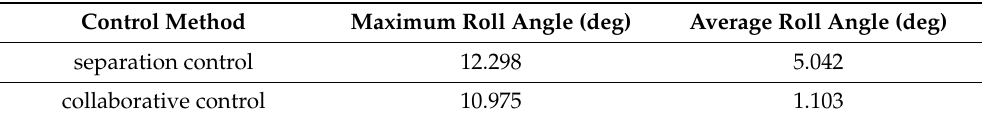
Table 8. Maximum roll angle and average roll angle of the collaborative control and separation